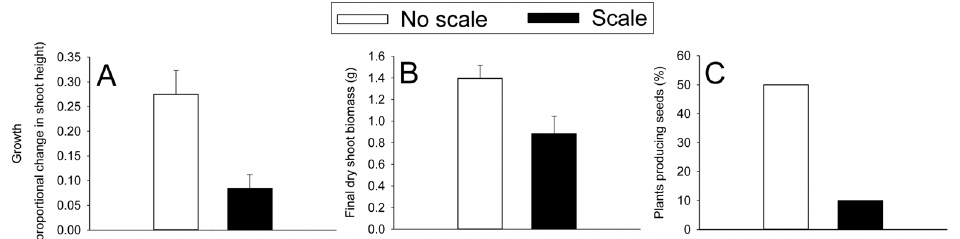
Figure 1. Scale effects on Spartina performance during the 2011 field experiment. The three performance measured included A) growth, B) final dry shoot biomass, and C) percentage of plants producing seeds. N=10. Values are means 6 SE.